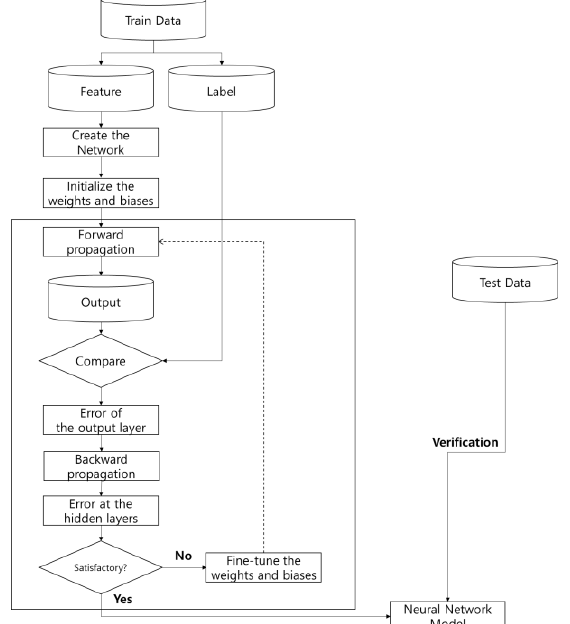
Figure 3. Modeling process of Deep neural network(Feed- forward neural network with Back-propagation